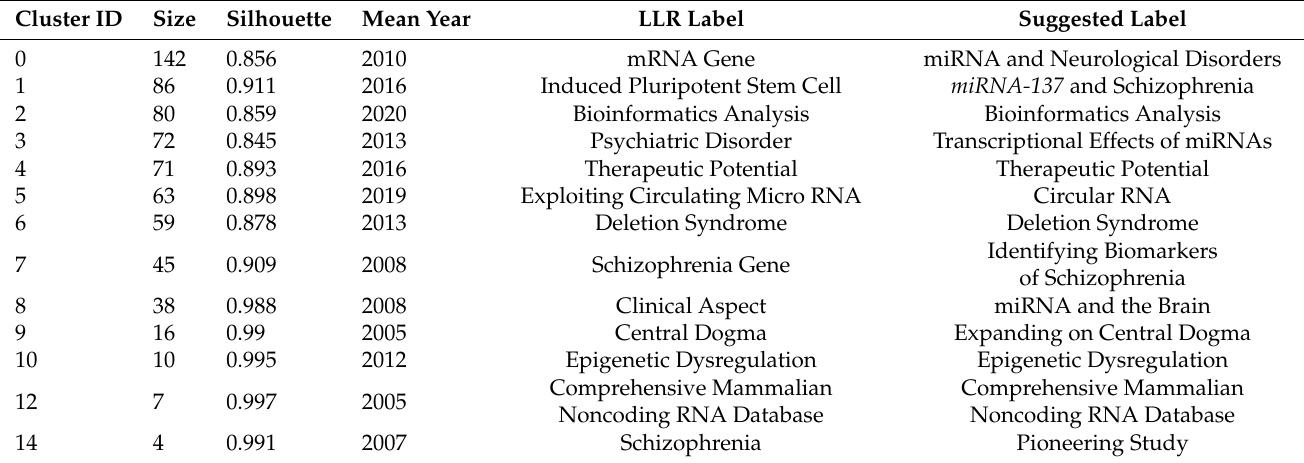
Table 1. Summary statistics for all clusters in final document co-citation analysis